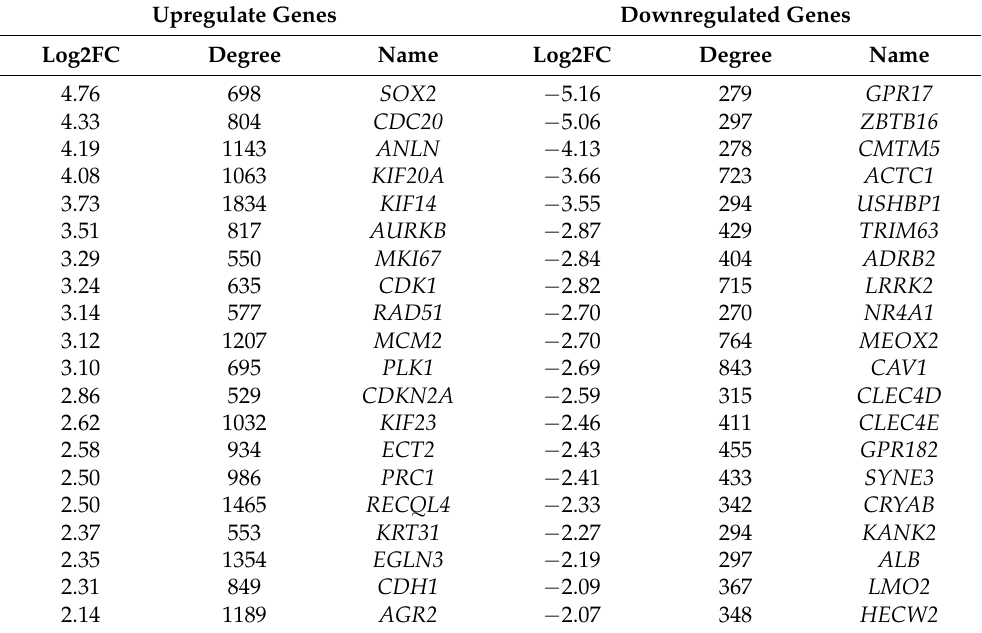
Table 2. The top 20 upregulated and 20 downregulated hub genes from the DEGs’ interaction network. Upregulate Genes Downregulated